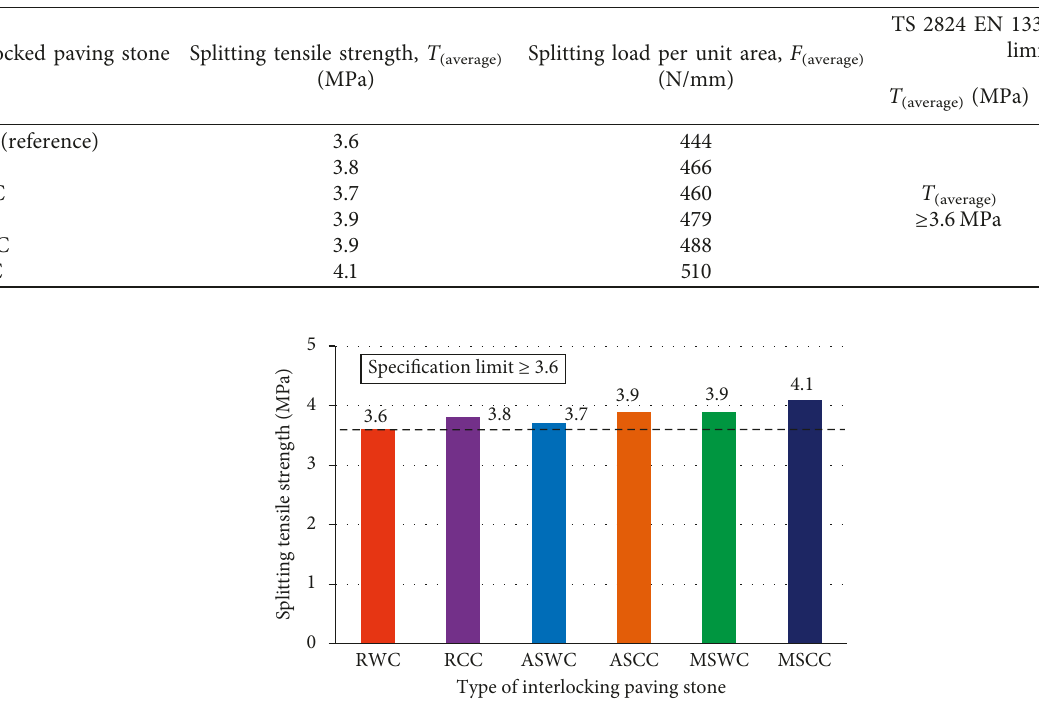
Figure 10: Results of the splitting tensile strength test for the interlocked paving